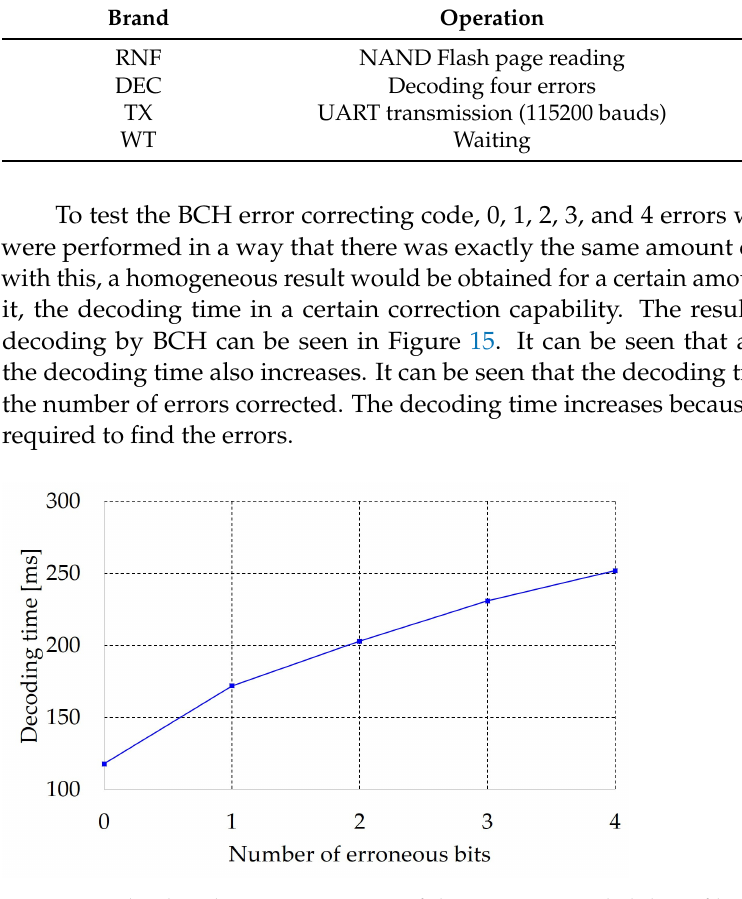
Figure 15. The decoding time increases if there is more probability of bit errors. If the read time increases, it is possible to predict the degradation of the NAND flash chip.